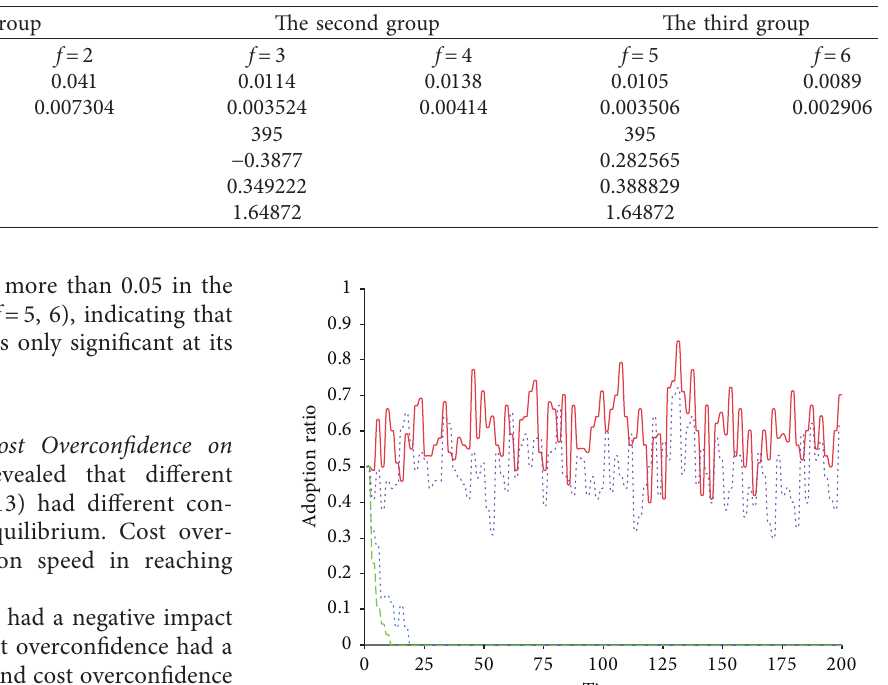
Figure 12: Influence of cost overconfidence on product diffusion behavior. Table 3: The t -test results of